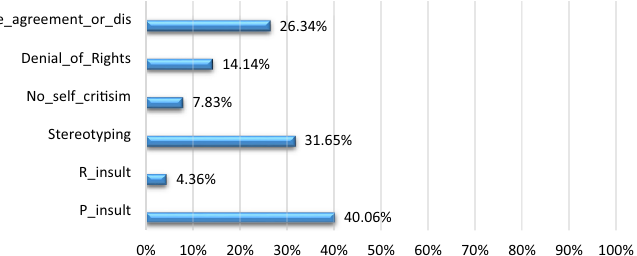
Figure 4. Group distribution in the full dataset